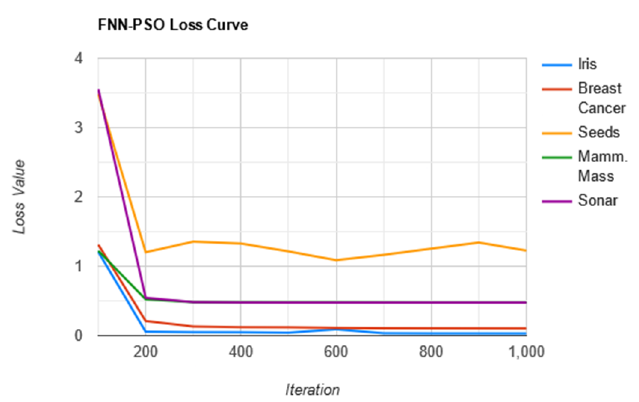
Figure 14. Loss curves of FNN-PSO algorithm for each data set over 1000 iterations.